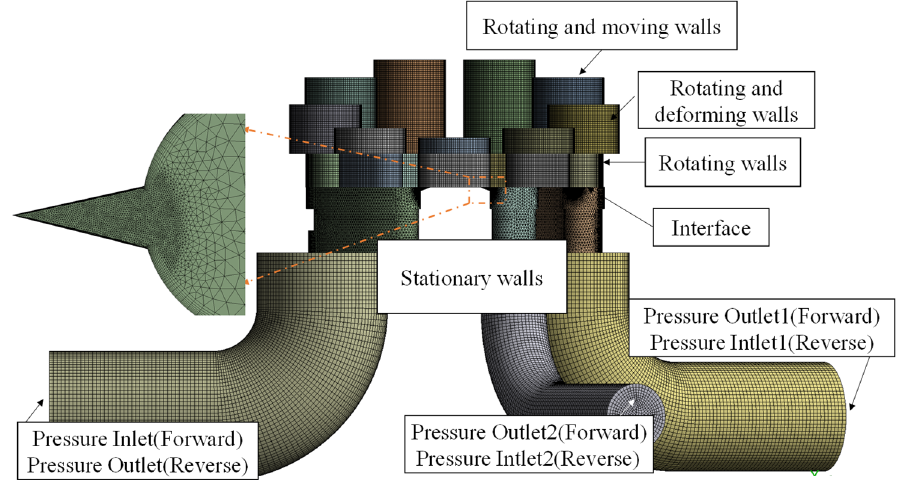
Figure 3. Mesh generation and boundary conditions